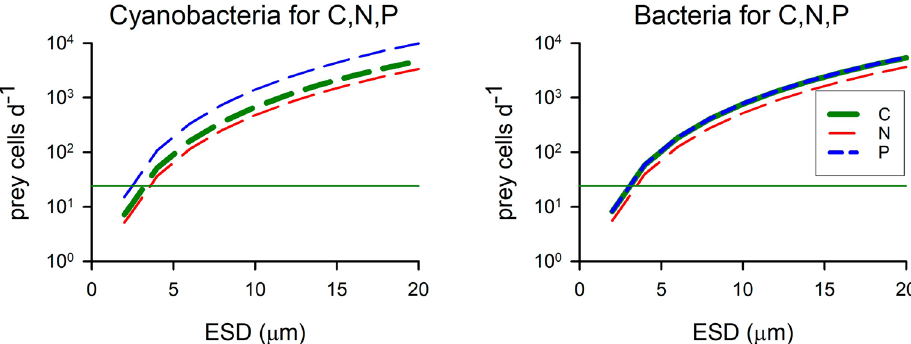
Figure 3. Ingestion rates of prey cells per mixoplankton cell required to satisfy all C,N,P structural needs for the replication of mixoplankton cells of different sizes. Prey were all assumed to be 1 µm ESD, as either heterotrophic bacteria, or as picophytoplanktonic cyanobacteria. The thin horizontal line, at 10 1.38 , indicates an ingestion rate of 1 prey h −1 . See also Fig. 2, and Figs. S4,